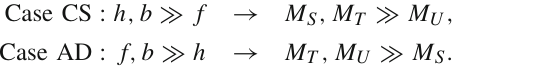
versus the value of the scalar potential at the critical